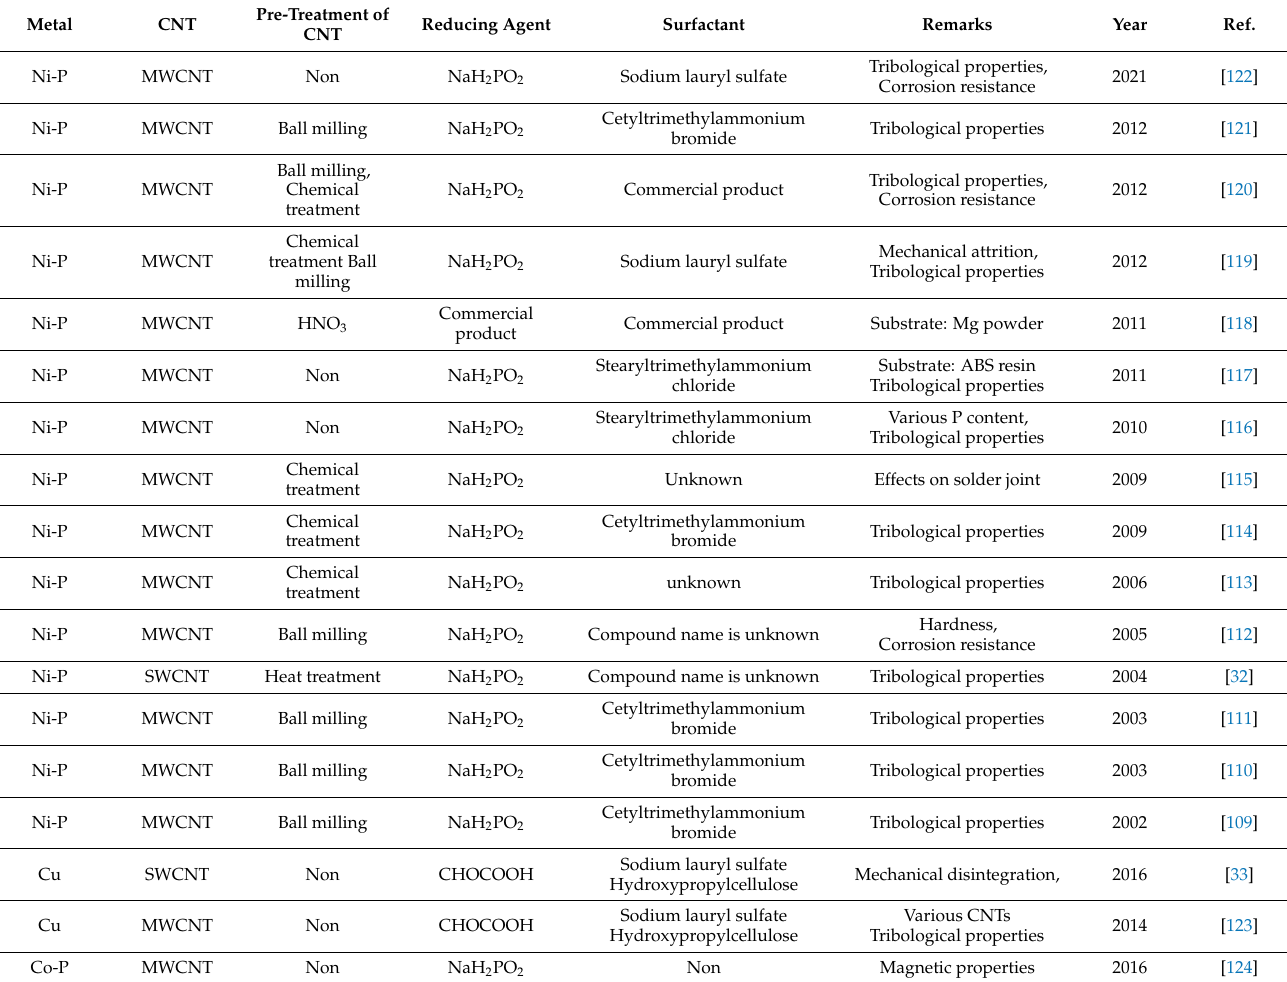
Table 2. Fabrication conditions of metal/CNT composites by electroless deposition.